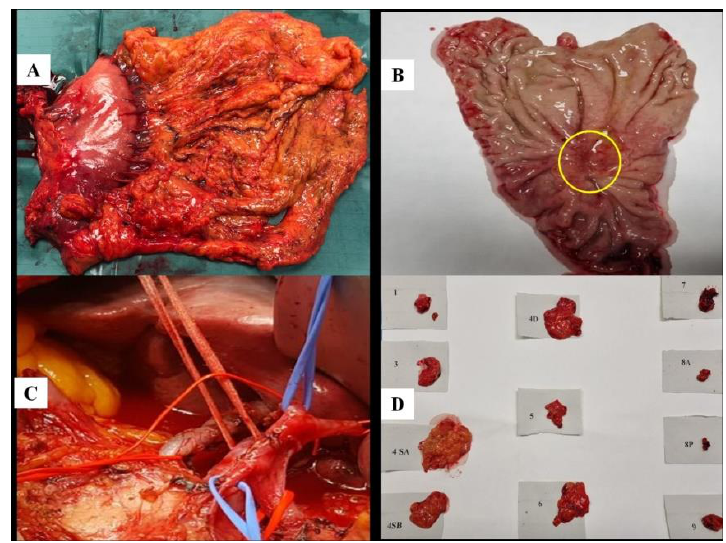
Figure 1. Lymph node harvesting according to the Japanese Gastric Cancer Protocol. ( A ): en bloc resection of stomach, omentum, lesser and greater curve adipose tissue. ( B ): the gastric specimen after perigastric lymph node harvesting, showing an ulcerated lesion of the angulus (encircled). ( C ): the surgical bed post central compartment lymph nodes removal. ( D ): the different lymph node stations separated and picked up.